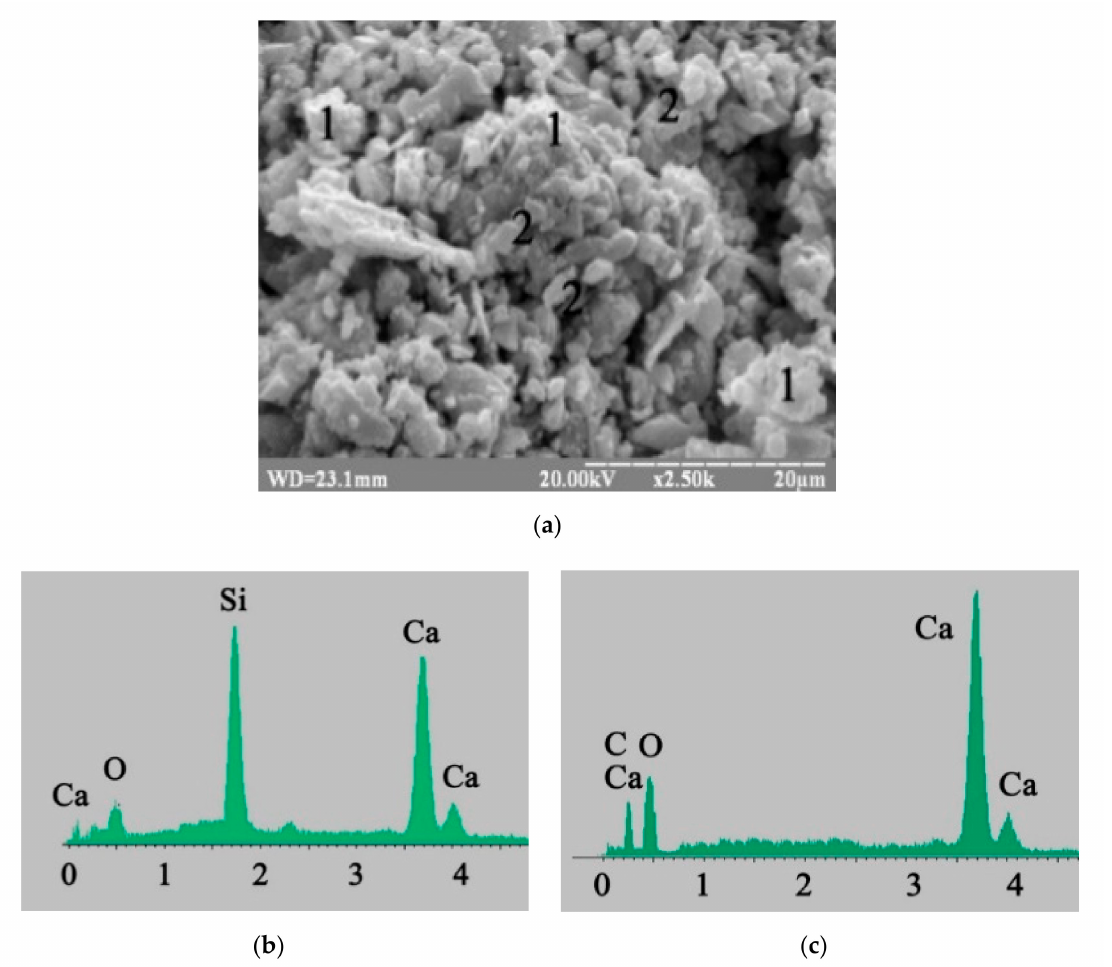
Figure 4. Microstructure of the 180-day hydrated blast furnace cement mixed with sea water and containing Na 2 CO 3 as minor additional constituents: ( a ) SEM image; ( b ) Microprobe analysis in point 1; ( c ) Microprobe analysis in point